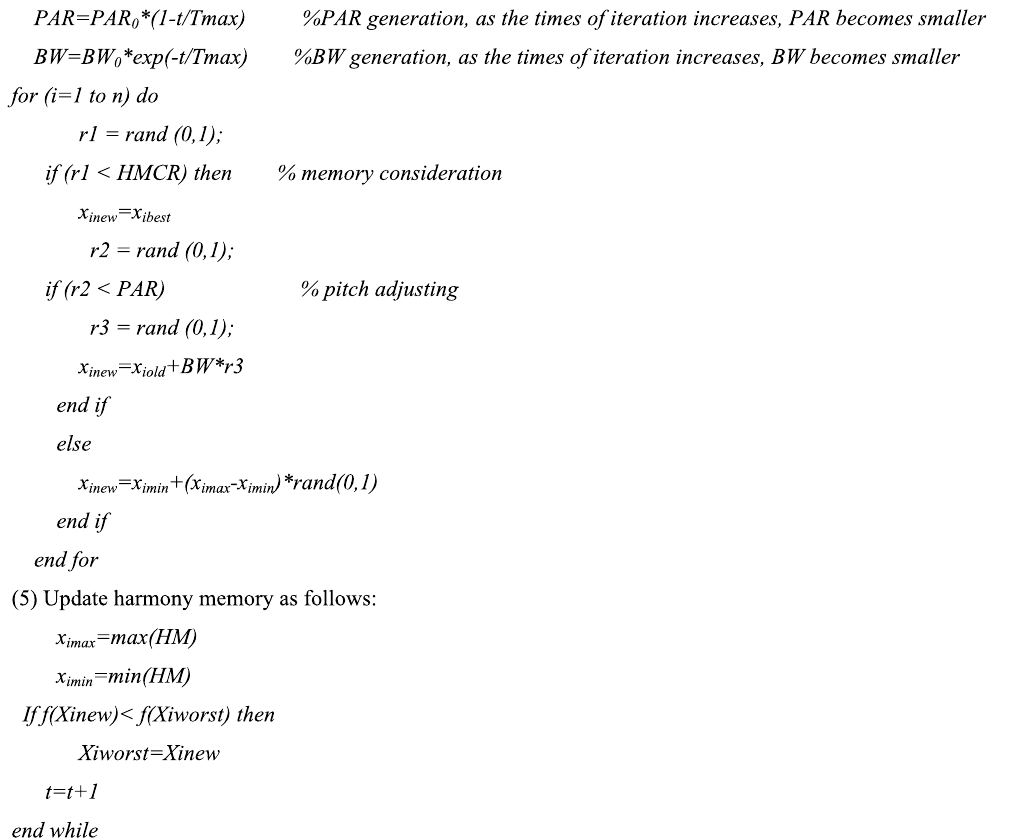
Table 3. Specific steps of HSA-F2